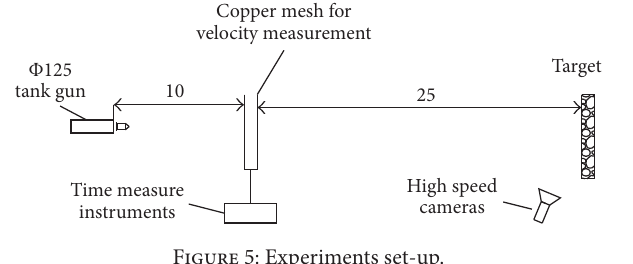
Figure 5: Experiments set-up.